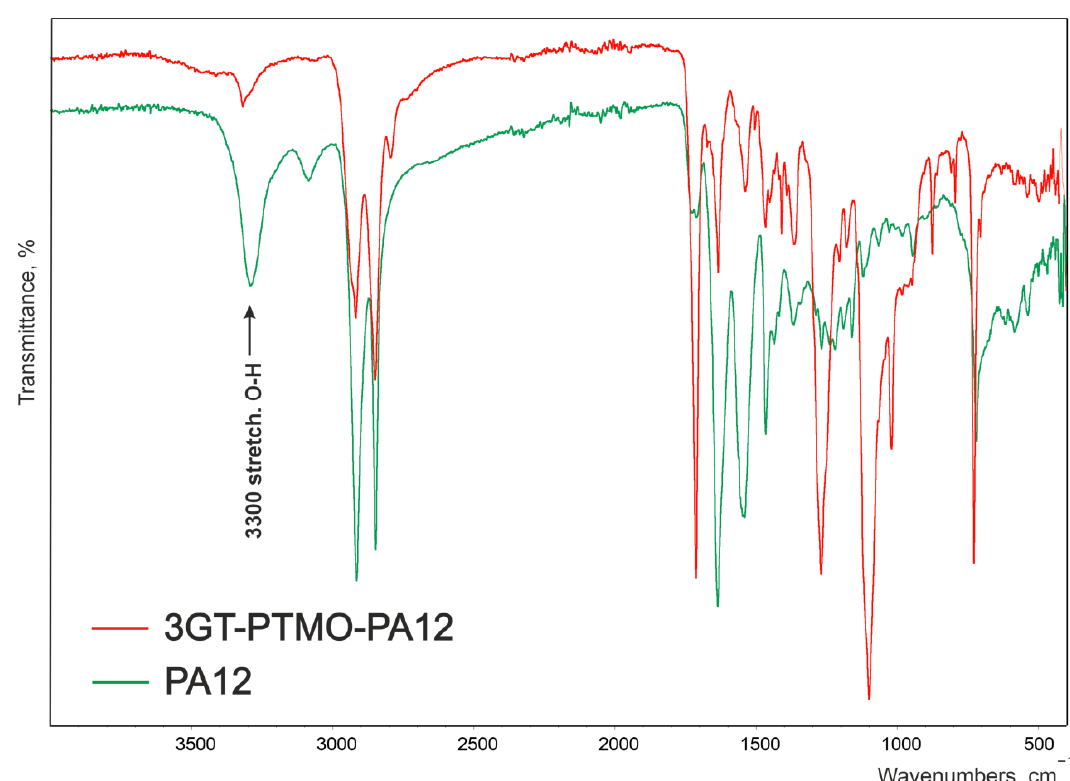
Figure 4. FT-IR spectrum of the reference terpolymer (3GT-PTMO-PA12) and PTMO homopoly- mer.